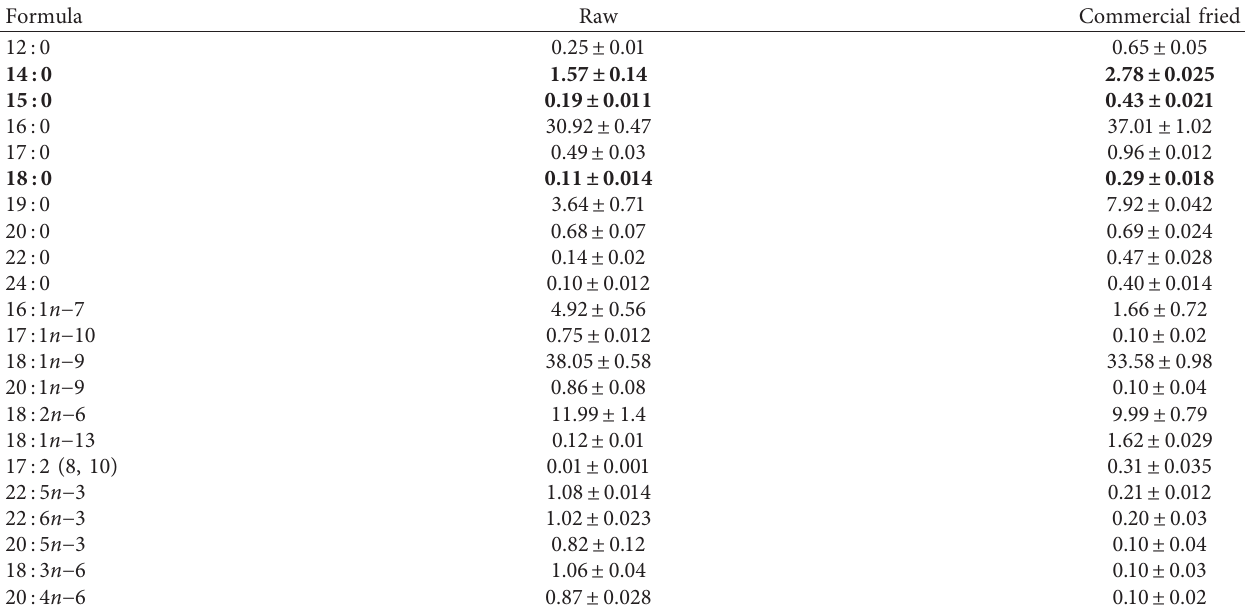
Table 2: Fatty acid composition of raw and commercial fried fish. Formula Raw Commercial